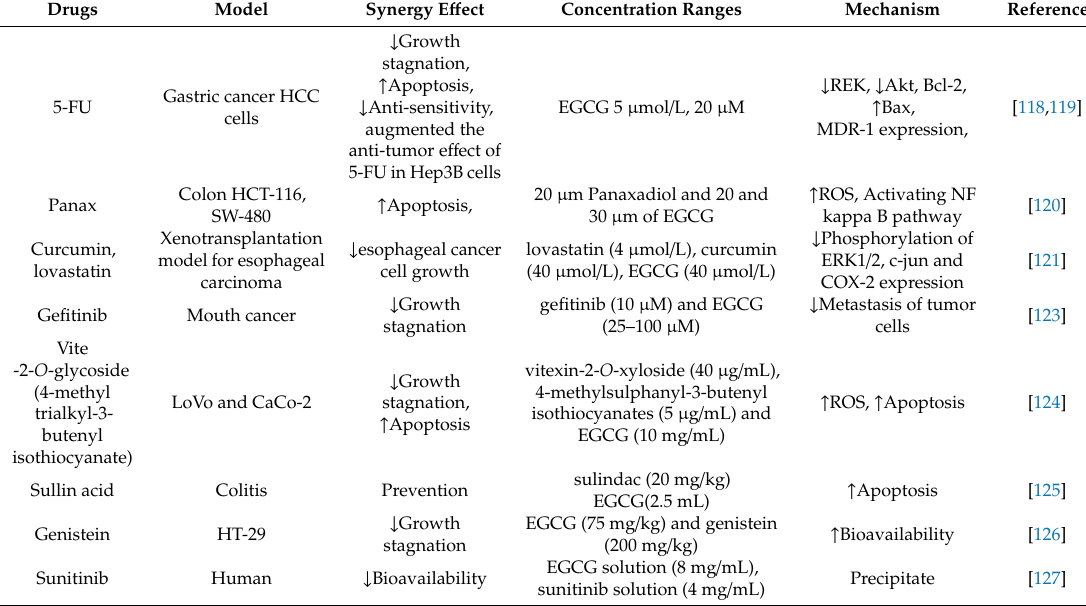
Table 1. Synergistic anticancer e ff ects of EGCG and other